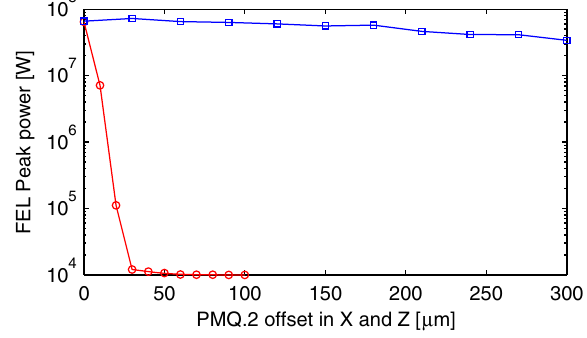
FIG. 14. FEL peak power at 200 nm at the undulator exit versus second PMQ radial offset (blue) with and (red) without orbit correction. Beam transport simulation in the nonlinear case with BETA and sympletic 6D tracking without collective effects using S2I-CM optics with r 11 ¼ r 33 ¼ 10 and r 56 ¼ 0 . 4 mm. FEL simulation with GENESIS.